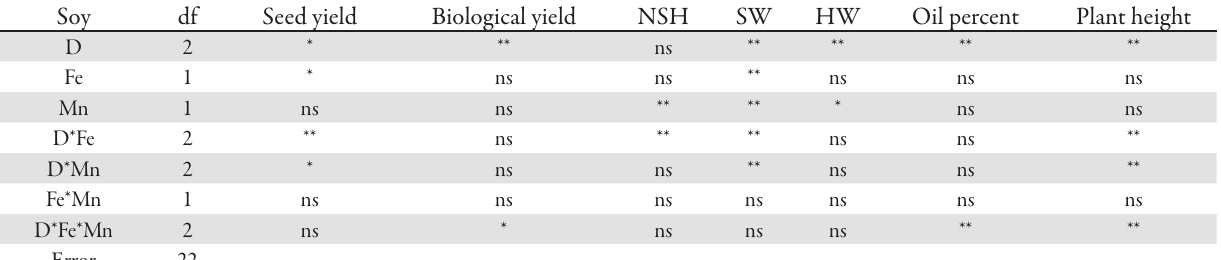
Tab. 6. Mean squares of ANOVA for oil percentage, biological and seed yield, yield components and plant height of